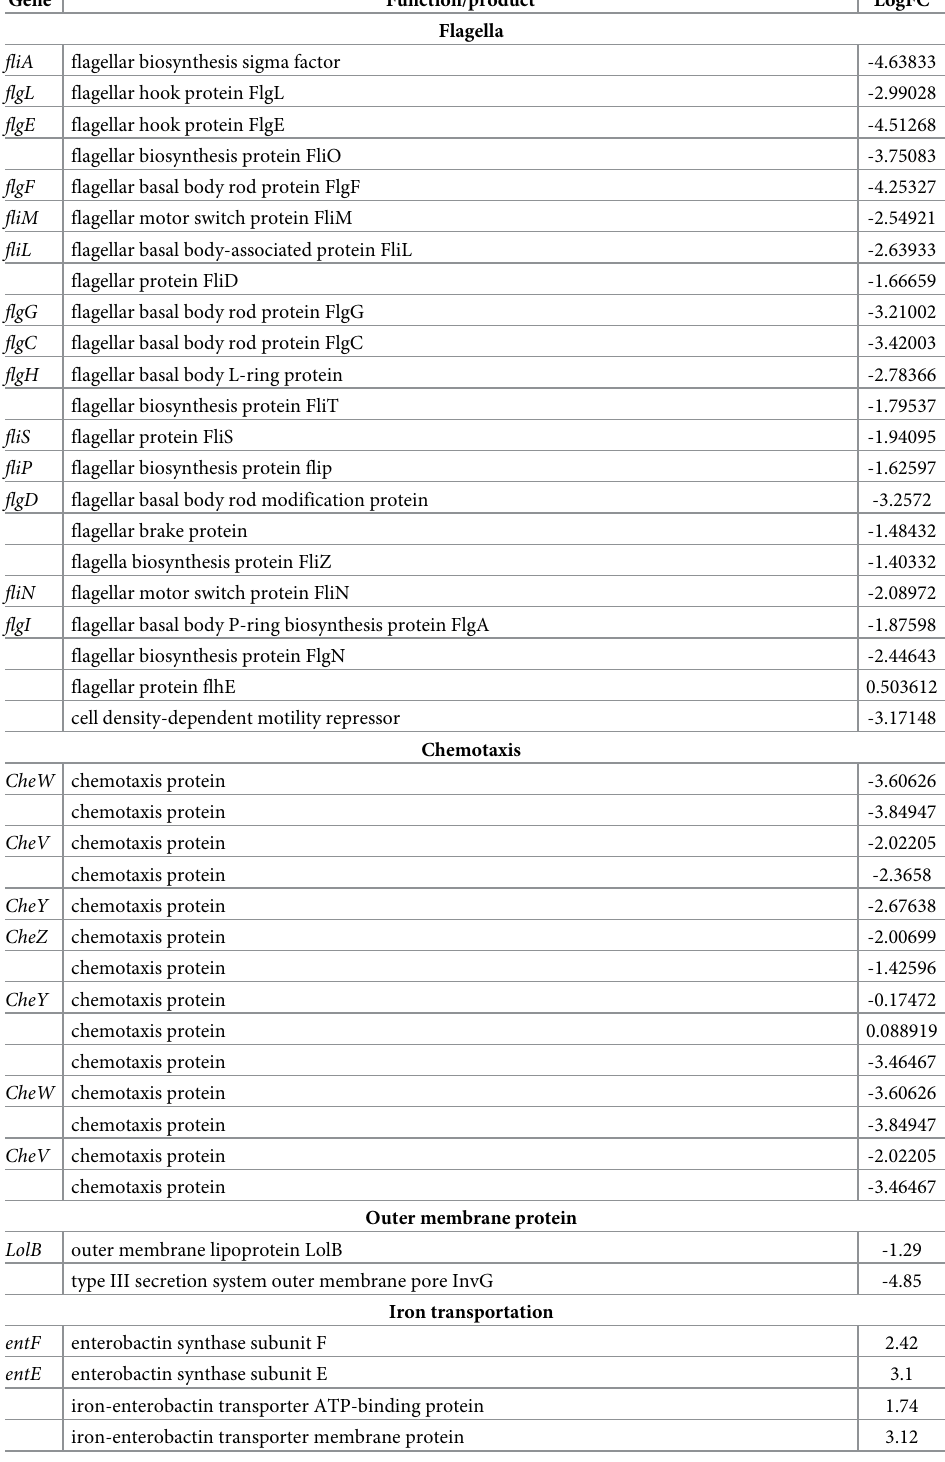
Table 3. List of genes regulated after the exposure to sub-inhibitory concentrations (2 and 4 mg/ml) of KCOH in S .